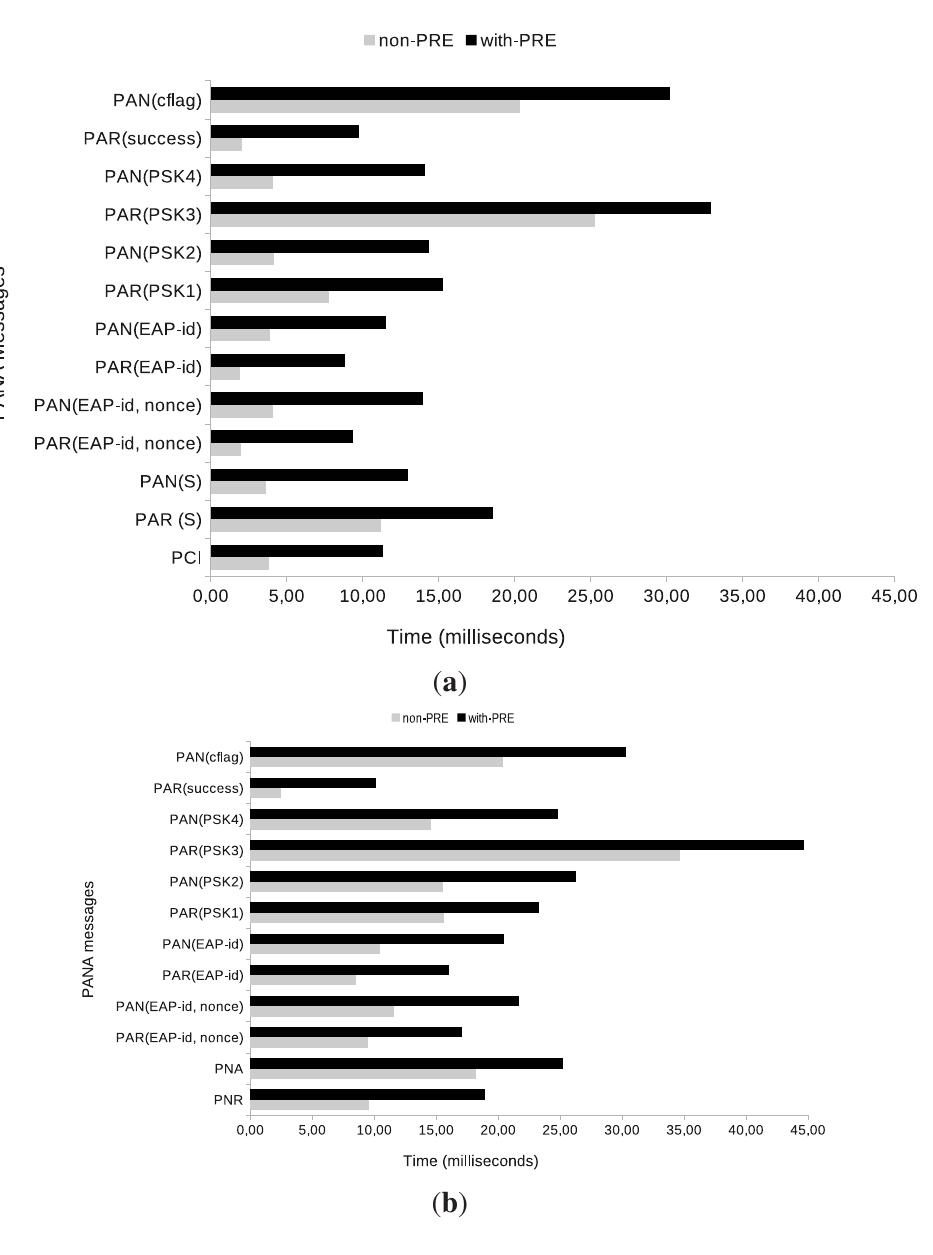
Figure 9. Mean processing time per message during the (re-)authentication phase (Note that in both cases, authentication and re-authentication, time(non-PRE) = messages processing time in PaC. Thus, time(with-PRE) = time(non-PRE) + messages processing time in PRE). ( a ) Mean processing time per message during the authentication phase; ( b ) mean processing time per message during the re-authentication